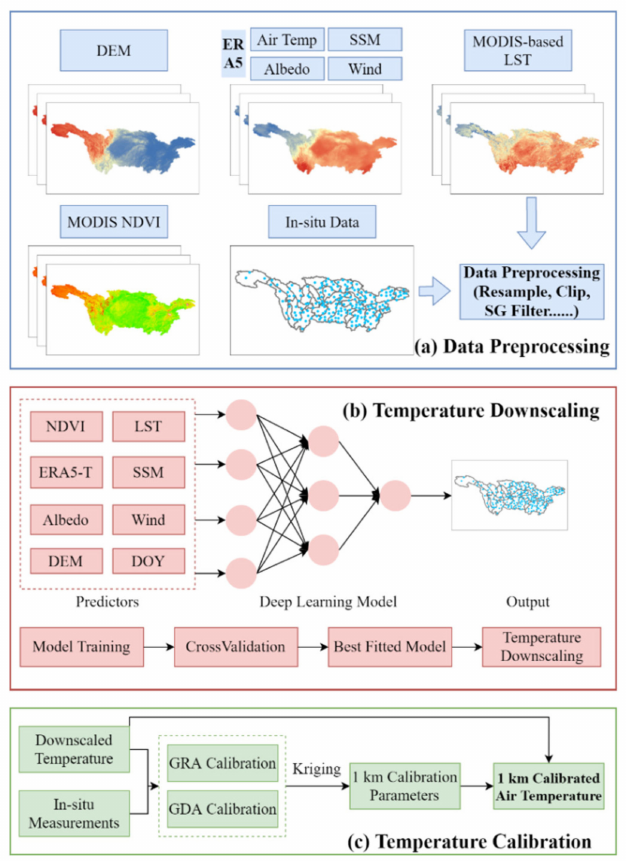
Figure 2. The methodology of temperature downscaling. The entire framework can be gener- ally divided into three parts including ( a ) data preprocessing, ( b ) temperature downscaling, and ( c ) temperature